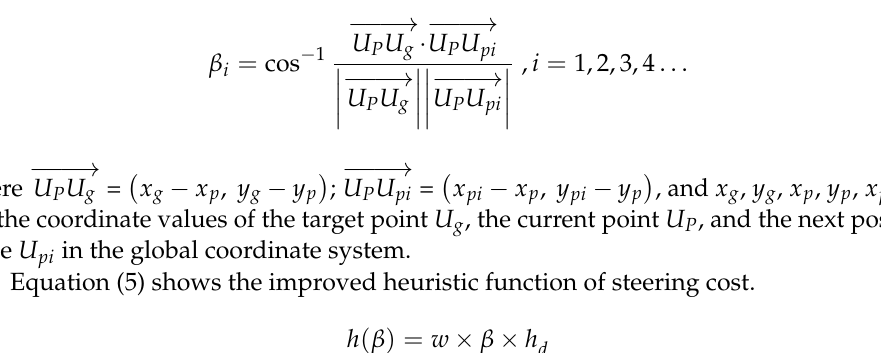
Figure 1. The vector representation from the current point to the travel point and the target point. The angle β can be calculated using the formula for finding the angle between two vectors in the global coordinate system.